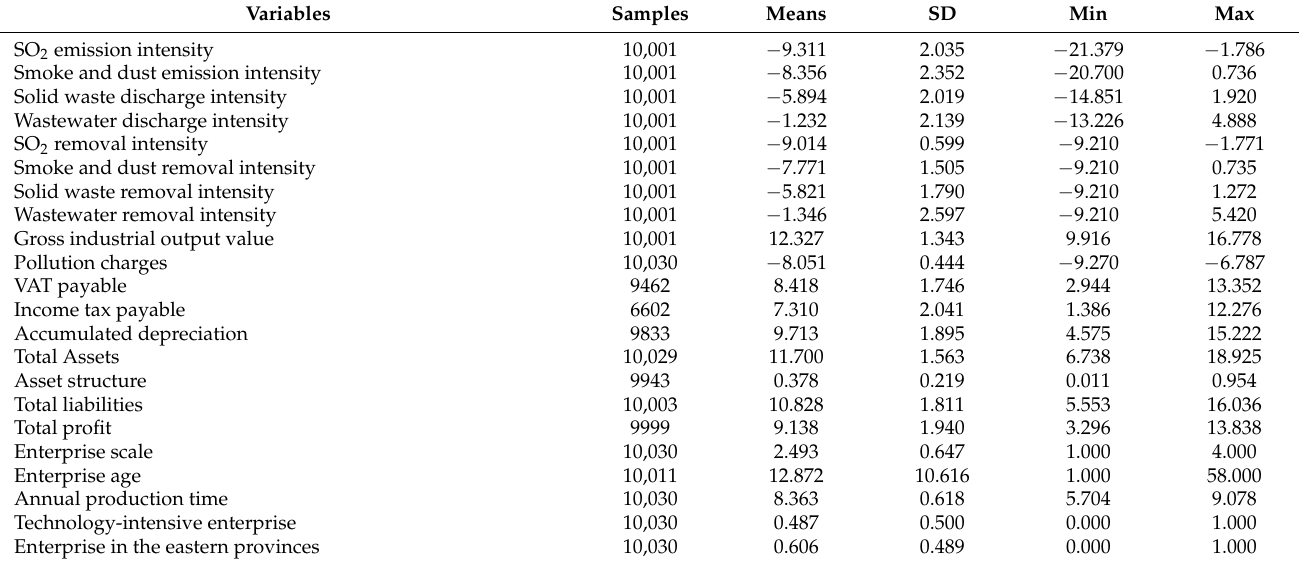
Table 1. Descriptive statistical results of the main variables for